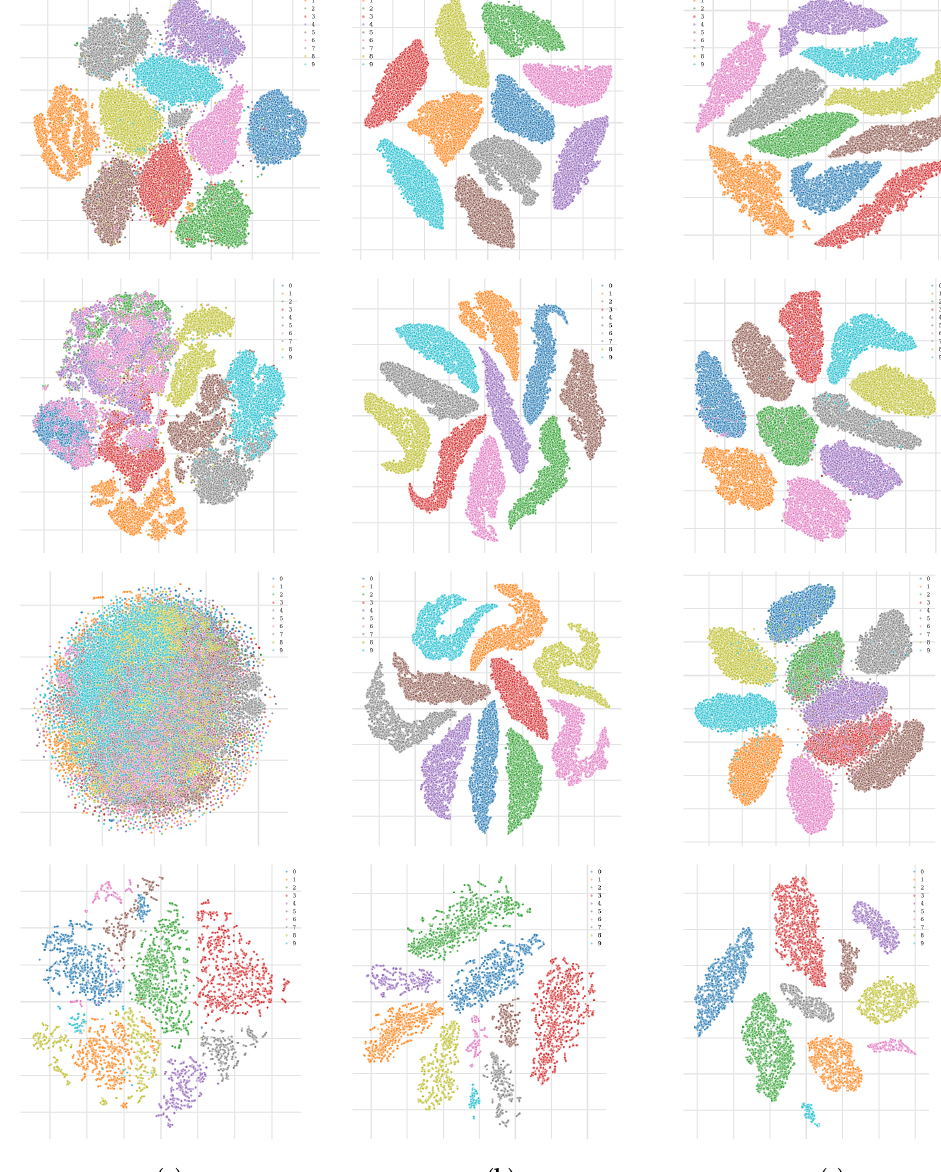
Figure 3. Comparison of training latent space representations (t-SNE projection) by different autoen- coder models for different datasets: MNIST (first block), Fashion-MNIST (second block), CIFAR10 (third block) and GTSRB (fourth block). We either used the triplet loss (TAE), the second variation of the PIRL (II-AE) or just the vanilla reconstruction loss (AE). Different colours represent different classes. ( a ) AE. ( b ) TAE. ( c ) II-AE